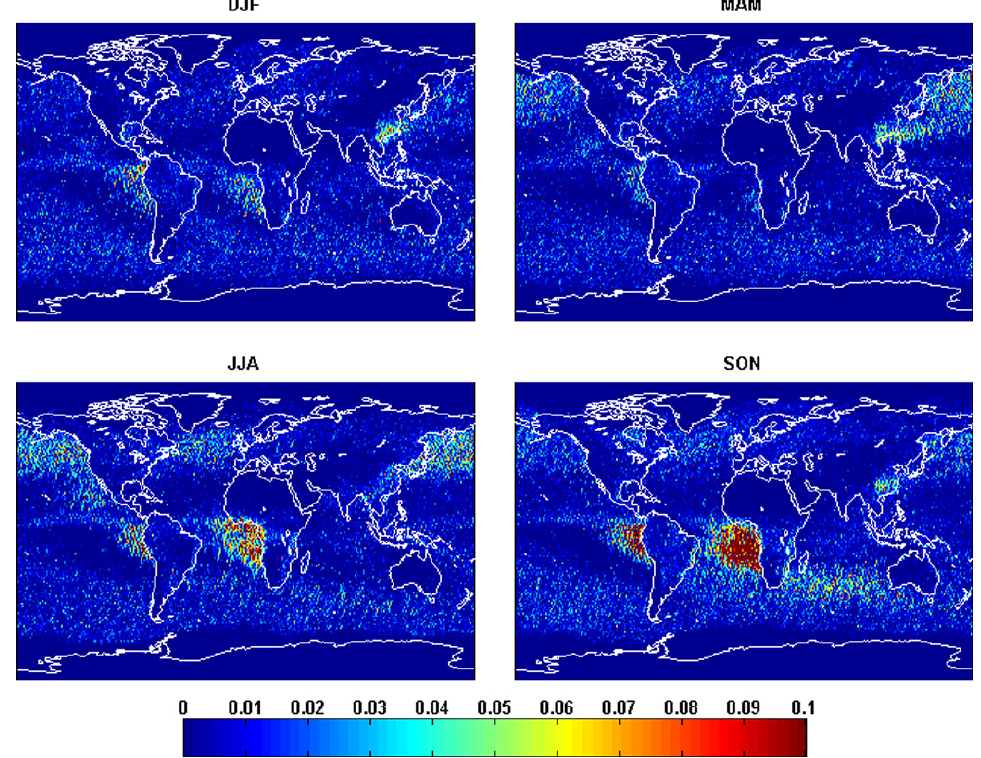
Fig. 4. Same is in Fig. 3, but for cases when only smoke layers are included in the